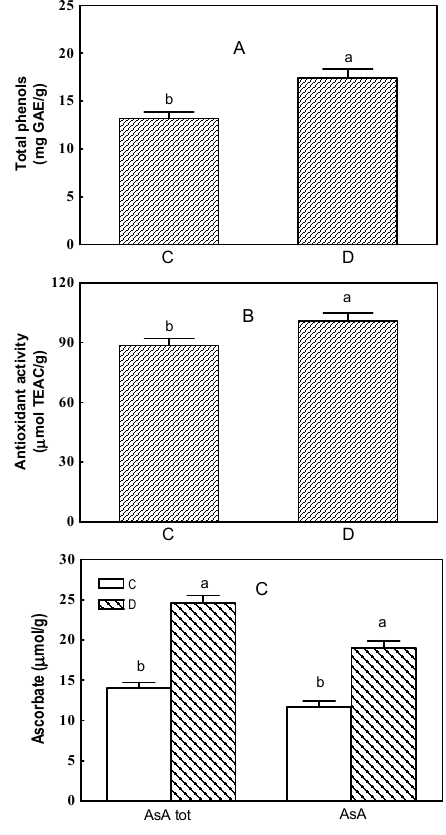
Figure 1. Total phenols ( A ), antioxidant activity ( B ) and ascorbate ( C ) in grape berries from control and defoliated vines of Vitis vinifera (Trebbiano variety). C, control; D, defoliated; AsA, reduced ascorbate. Data are reported as mean values ± standard error. For each compound means accompanied by different letters are significantly different at p ≤ 0.05.